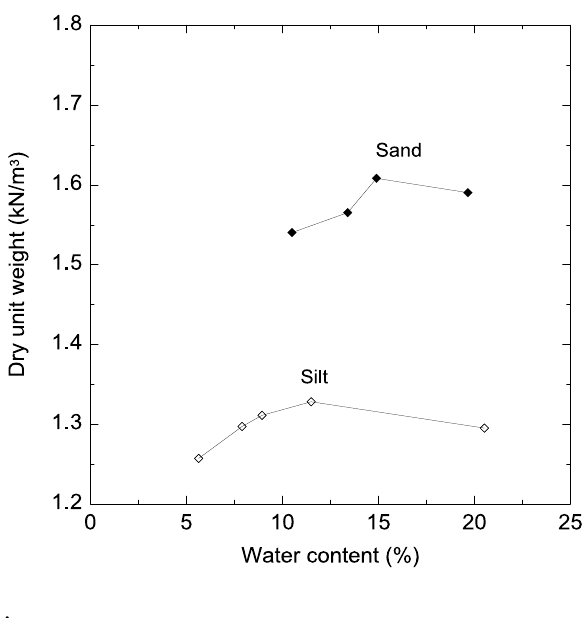
Figure 3. Compaction curves of sand and silt used in the